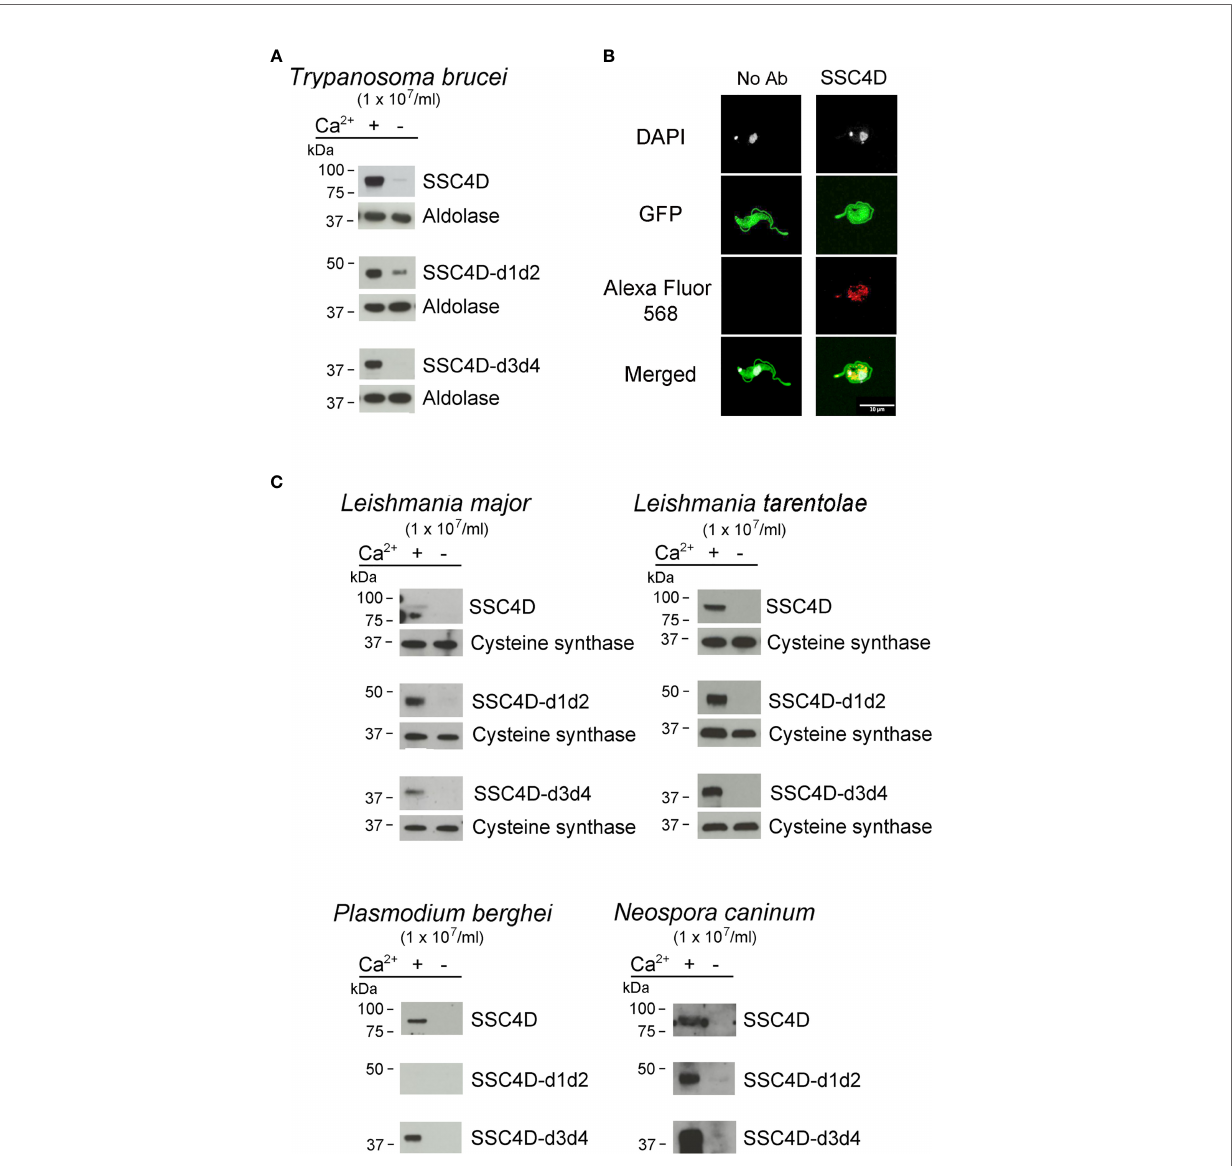
FIGURE 6 | SSC4D binds to protozoan parasites. (A) Two micrograms of recombinant SSC4D, or of the hemi-forms SSC4D-d1d2 and SSC4Dd3d4, were incubated with suspensions of 1 × 10 7 live Trypanosoma brucei brucei bloodstream forms in the presence or absence of Ca 2+ . Parasite-bound proteins were detected by immunoblotting using anti-HIS mAb. Membranes were reprobed with an anti-aldolase immune serum for loading control. Results shown are of one of three independent experiments. (B) Representative images of SSC4D interacting with green fl uorescent protein (GFP)-expressing T. brucei . In both panels, GFP + parasites (green) were allowed to interact with SSC4D (red), being the primary antibody omitted in the left panel, as control. DAPI (white) indicates DNA staining. The results shown are representative of four independent experiments. (C) Two micrograms of recombinant SSC4D, SSC4D-d1d2, and SSC4D-d3d4 were incubated with suspensions of 1 × 10 7 live Leishmania major and Leishmania tarentolae promastigotes, Plasmodium berghei merozoites, and Neospora caninum tachyzoites. Interactions were detected as in panel (A) , and membranes were reprobed with an anti- L. infantum cysteine synthase immune serum for loading control of L. major and L. tarentolae